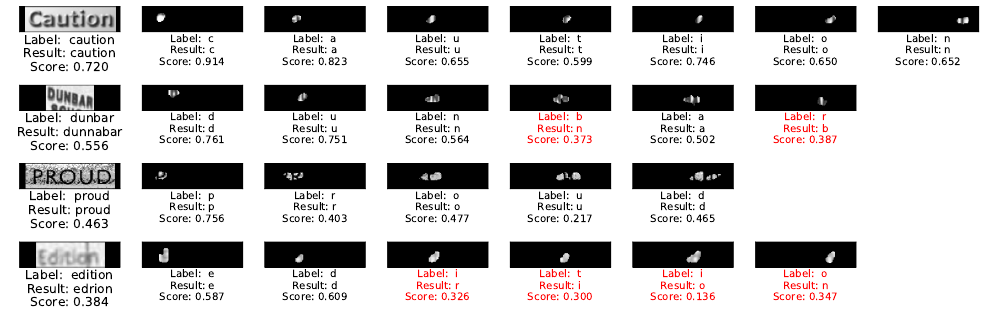
Figure 8. Samples text images from benchmark with the corresponding quality scores of each character in